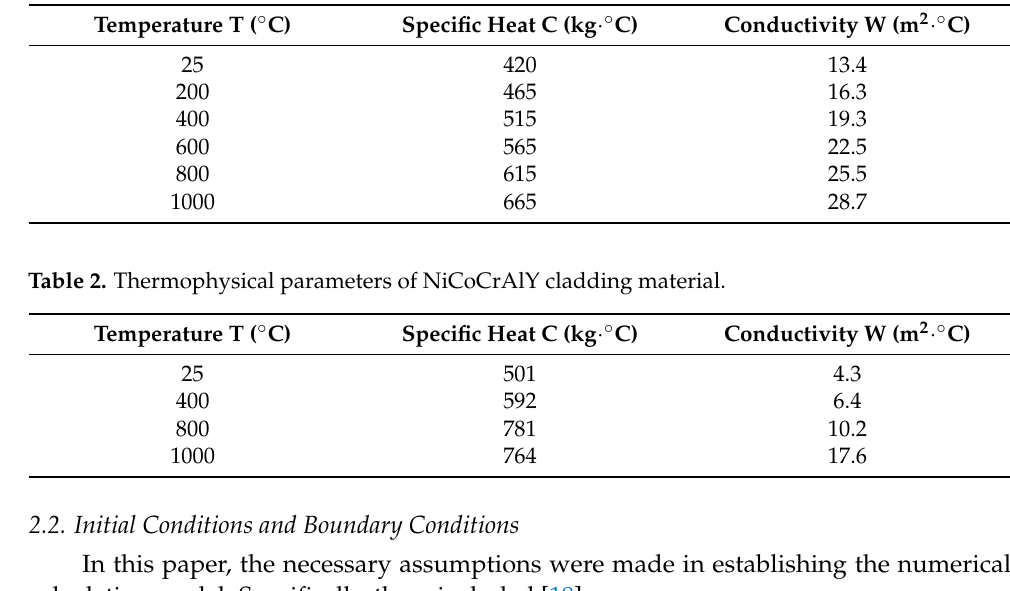
Table 1. Thermal properties of Inconel617 substrate.